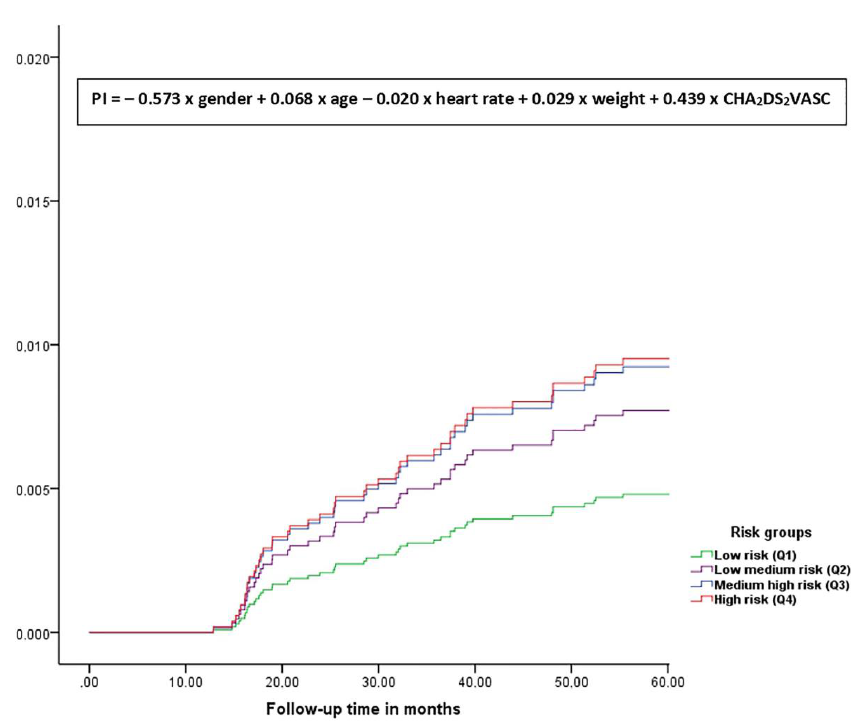
Figure 1. Function for predicting AF risk at 5